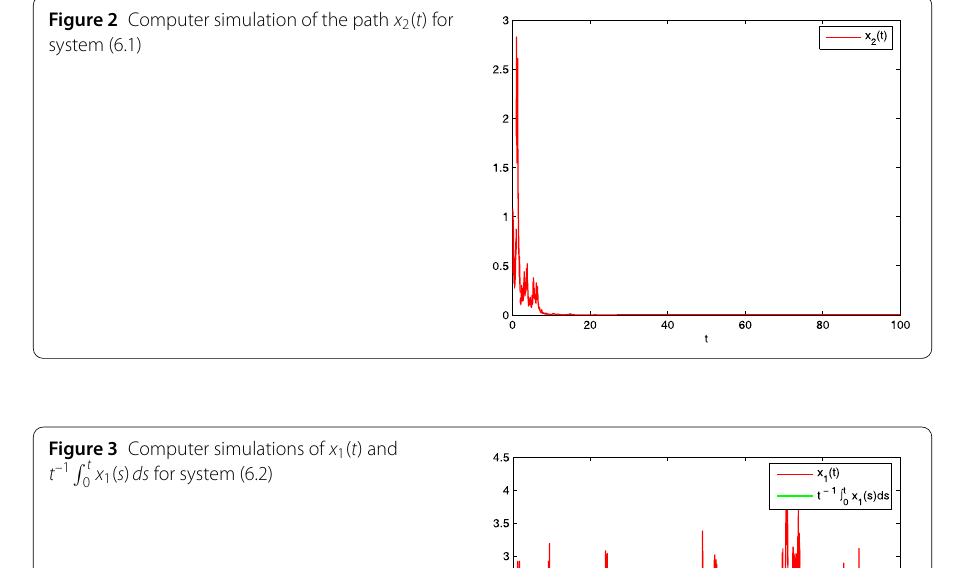
Figure 3 Computer simulations of x 1 ( t ) and x 1 ( s ) ds for system (6.2) t –1 t 0